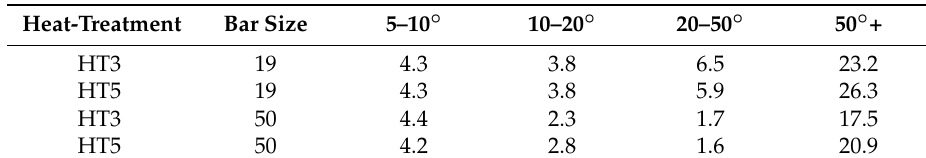
Table 3. The length of boundaries per unit area ( µ m − 1 × 10 2 ) for the different samples between certain misorientation angles, taken from the data in Figure 4.